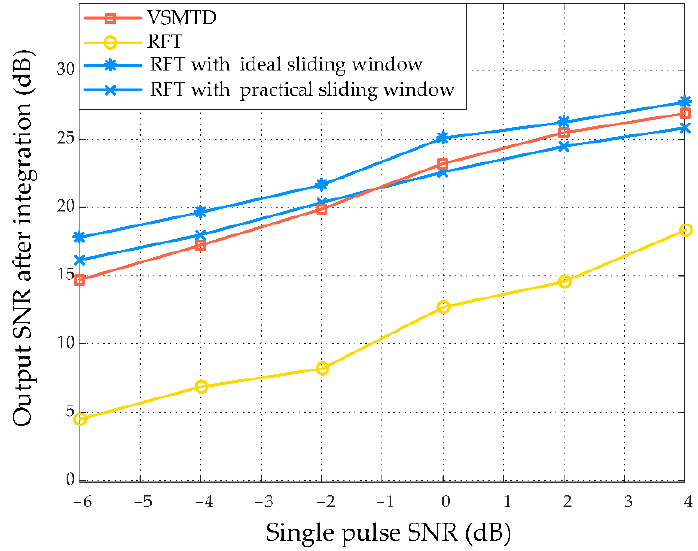
Figure 20. Comparison of different range integration strategies.